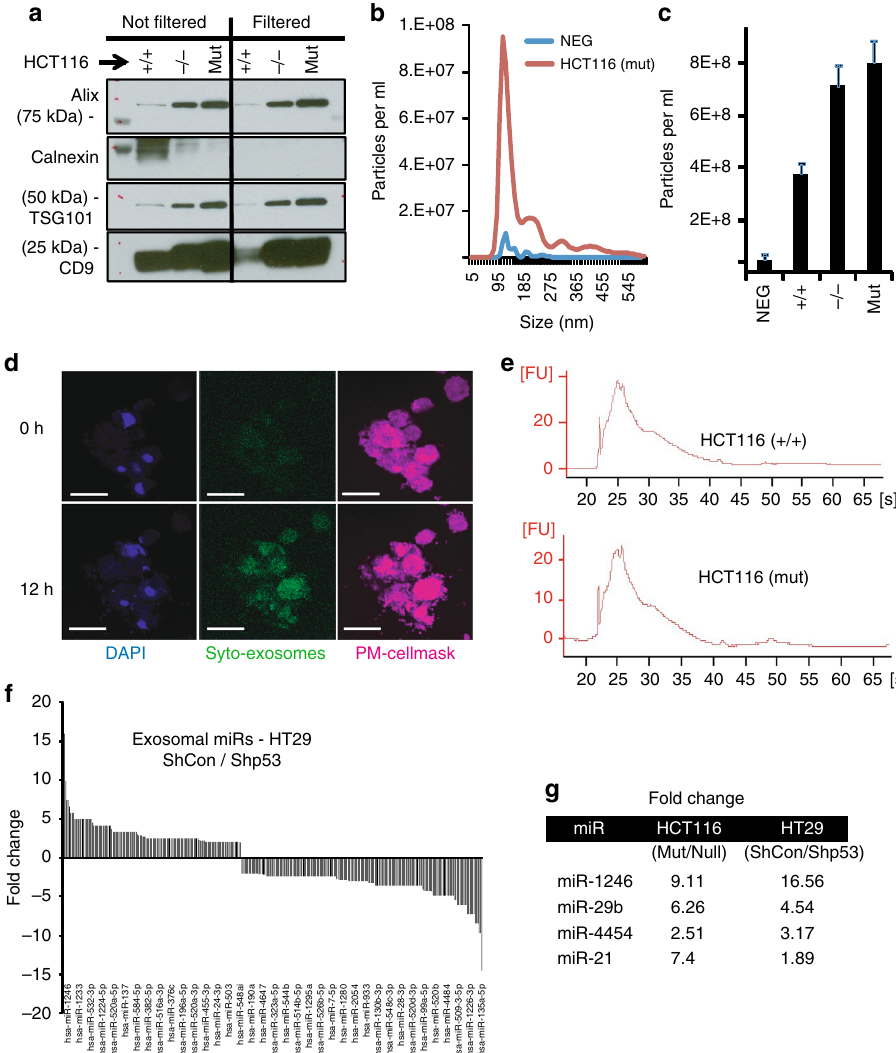
Fig. 2 Exosomes shed from tumor cells are taken up by neighboring macrophages. a Exosomes were isolated from HCT116 cells harboring either WT, mutant (R248W), or no p53 as described in the Methods section. Isolations were either fi ltered (0.22 µ m) or kept un fi ltered during the procedure. Subsequently, isolations were lysed and subjected to western blot analysis with the indicated antibodies for exosomal markers. Calnexin served as a cellular contaminants marker. b , c Exosomes isolated from HCT116 cells underwent a nanoparticle tracking analysis (NTA) to determine exosomal size distribution ( b ) and concentration ( c ). The exosome samples were compared with cell-free medium that underwent similar isolation procedure (NEG). d Exosomes isolated from HCT116 cells were labeled using a Syto RNAselect dye before being incubated with macrophages for periods of 24 or 48 h. Accumulation of exosome uptake was captured in time-lapse movies. Macrophage nuclei are labeled with DAPI, plasma membranes are labeled with CellMask far-red. Bars = 25 µ m. e RNA was extracted from HCT116-derived exosomes and its integrity and quality were tested using a bioanalyzer system before it was subjected to miRNA expression assay and normalized to the most abundant 100 miRs. f A representative comparison displaying greater than twofold changes in miRs between HT29 cells either knocked down for mutp53 (Shp53) or not (ShCon). g Changes in expression for four prominent miRs that were found to be signi fi cantly more abundant in mutp53 HCT116 and HT29